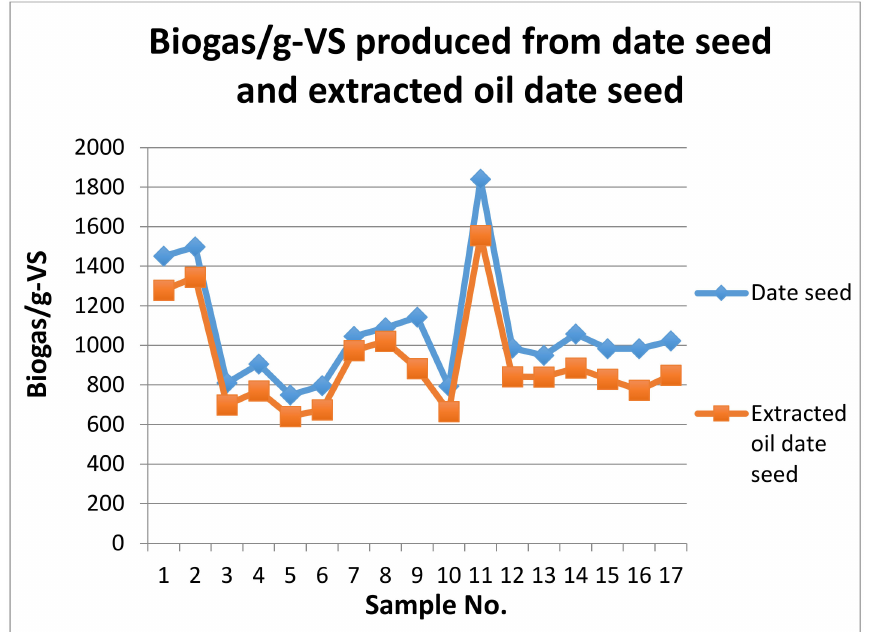
Figure 39. The variation in the Biogas/g-VS quantity of date seed and extracted oil date